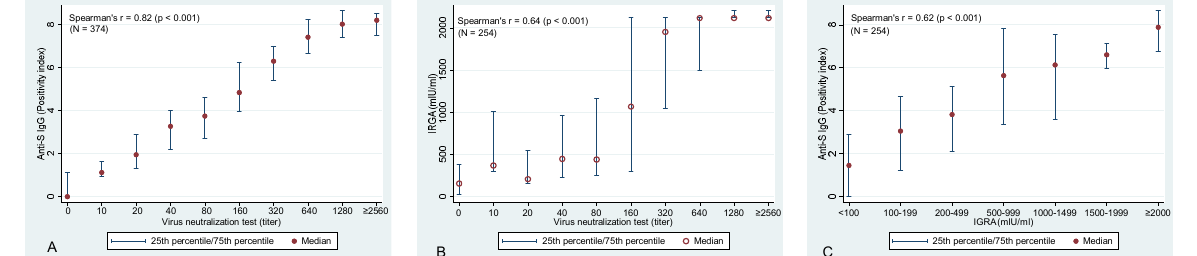
Figure 2. Association between ( A ) VNT and anti−S IgG antibodies, between ( B ) VNT and T−cell- mediated immunity (IRGA), and between ( C ) IGRA and anti−S IgG antibodies. Please note that 2560 is the highest used titer of VNT and, hence, it is likely that for many of these samples, an even higher titer would be detected if dilution series continued. The same applies to IGRA values with the maximum value of 2115 mlU/mL.